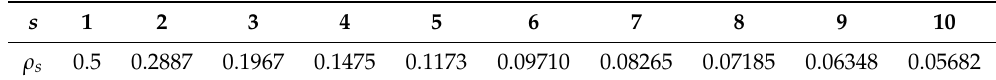
Table 1. A few values of the parameter defined at